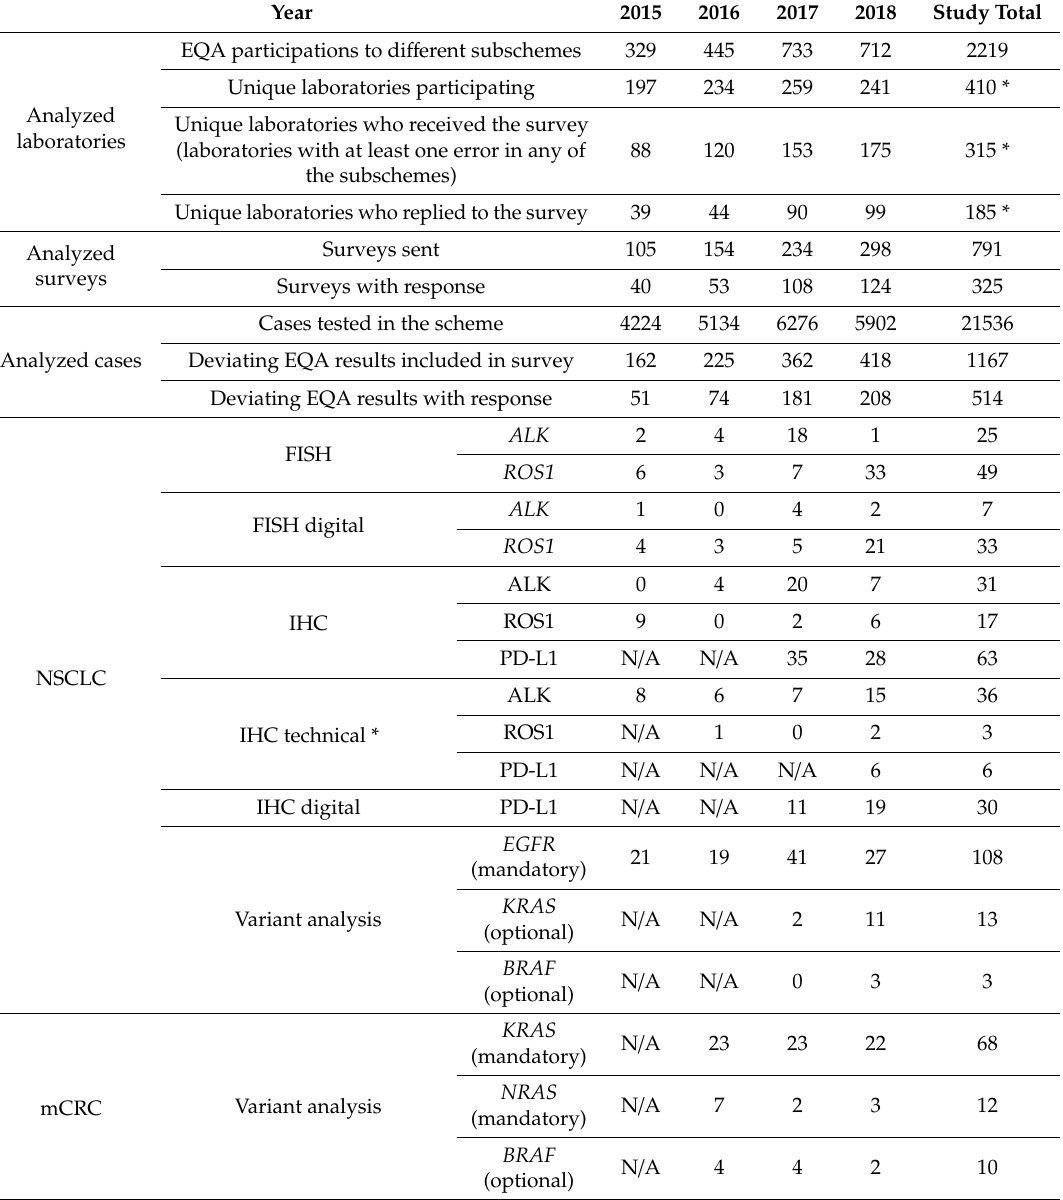
Table 1. Number of cases analyzed per subscheme o ff ered in the European Society of Pathology (ESP) external quality assessment (EQA)